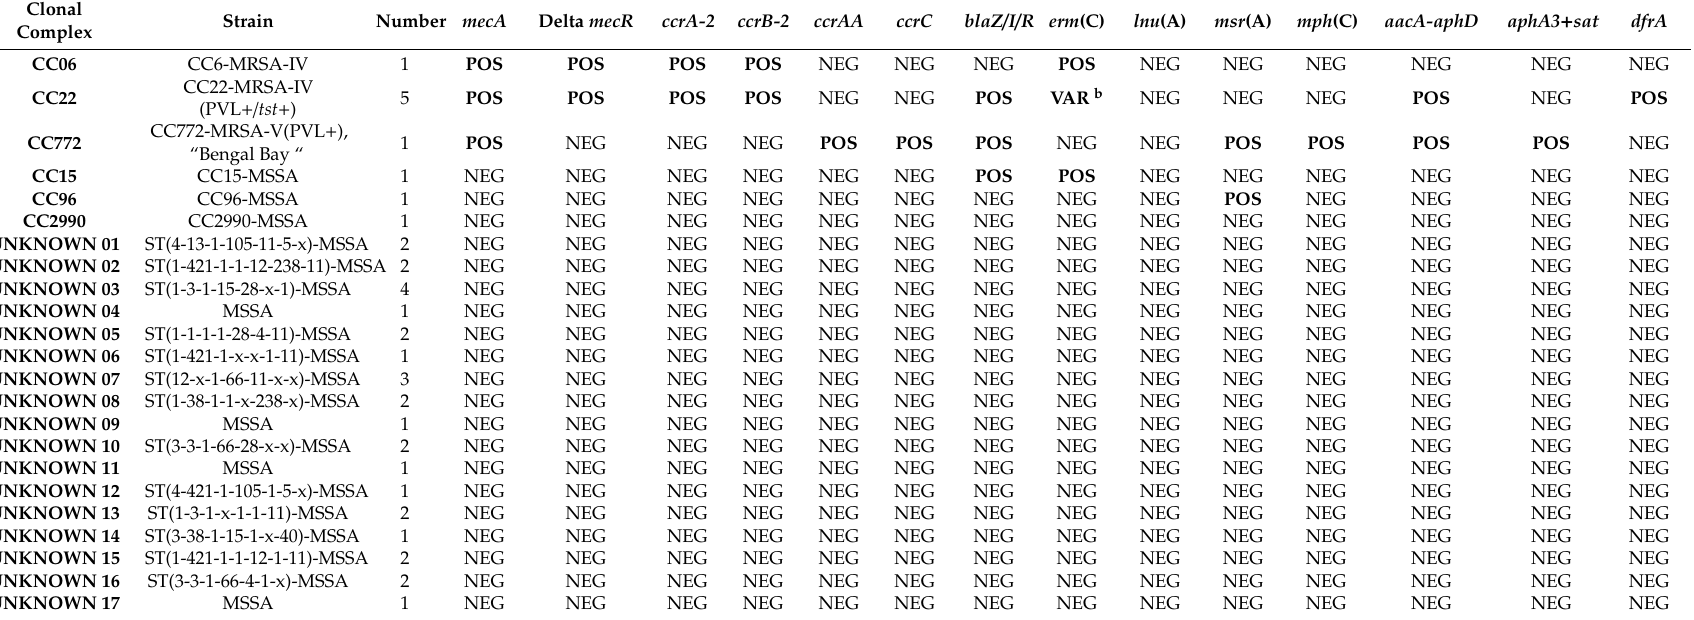
Table 3. SCCmec markers and resistance genes a